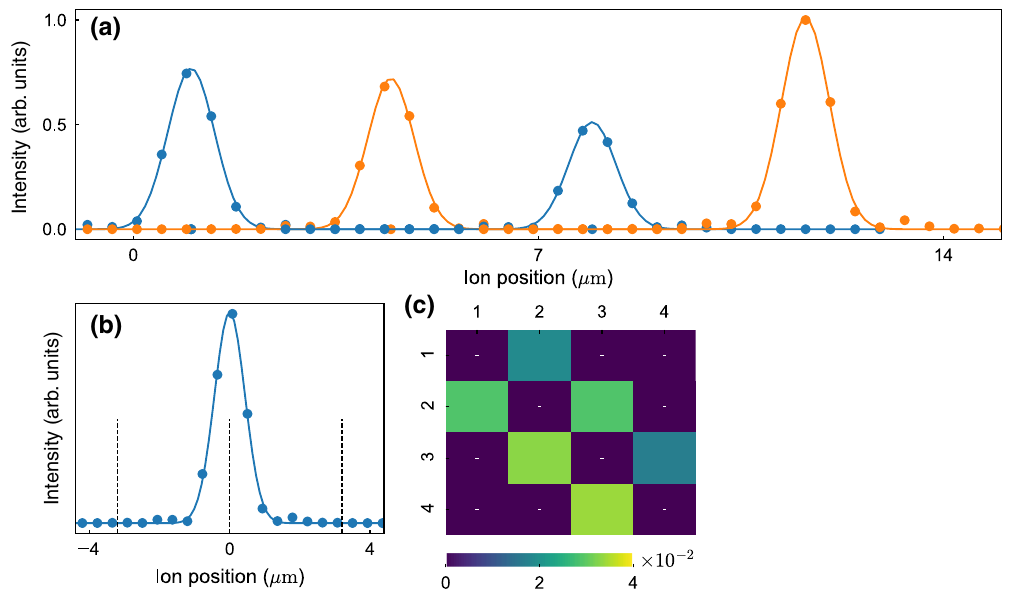
FIG. 12. Micro-optics addressing unit performance. (a) A single ion’s position is scanned electrostatically along the trap axis by varying the endcap voltages. The square of the Rabi frequency is plotted as a function of this position for four active channels at a distance of 3.4 μ m. Solid lines are Gaussian fits to data, alternating colours for clarity. (b) Same as (a) with higher resolution for spot size measurement of the focused addressing beam at 729 nm. By fitting a Gaussian distribution to the data we obtain a beam width of w 0 ≈ 0.8 μ m. Dashed black lines indicate the nearest neighbors for a 50-ion crystal at the minimal distance of approximately 3.2 μ m. (c) Estimates of resonant crosstalk from intensity profiles in (a). The dashed entries in (c) are not